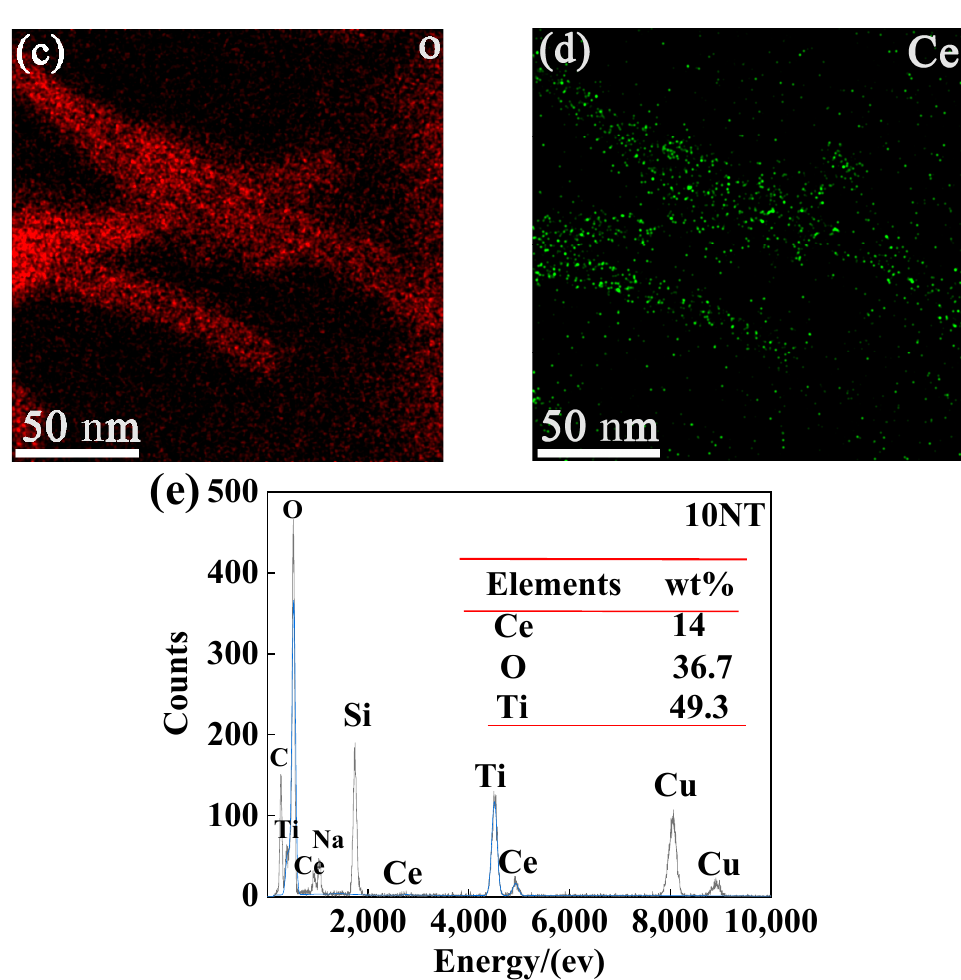
Figure 2. HRTEM morphologies and EDS analysis of the 10 mol% Ce-doped TNT. ( a ) HR-TEM image; ( b ) Ti; ( c ) O; ( d ) Ce; and ( e ) Sum spectrum of the area covering the map.